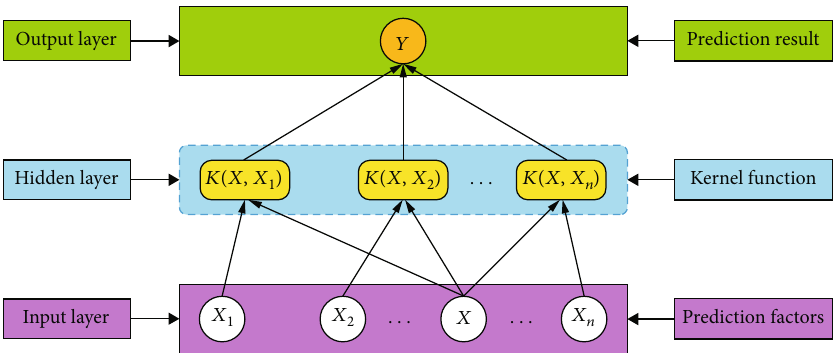
Figure 1: The basic structure of